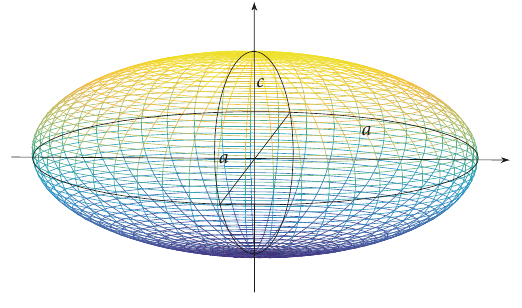
Figure 1: A ellipsoidal protected